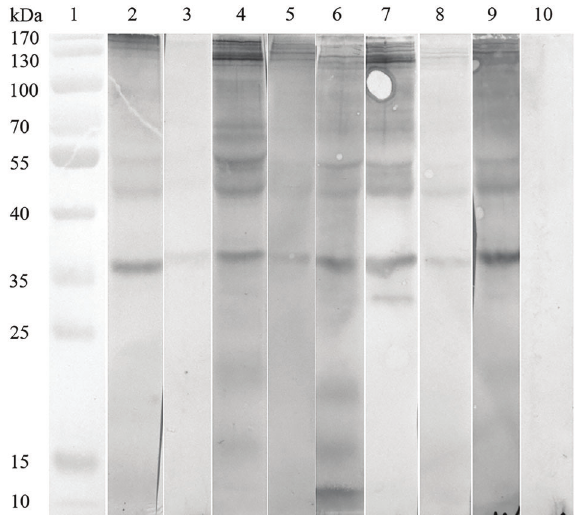
Figure 2 . SDS-PAGE and IgG1 immunoblotting of the crude antigen of Echinococcus granulosus cyst fl uid (EgCF). Crude antigens of EgCF protein extracts were incubated individually with 8 sIgG1 positive sera ( lanes 2 – 9 ), and with disease control ( lane 10 ); protein molecular weight marker ( lane 1 ). SDS-PAGE, sodium dodecyl sulfate-polyacrylamide gel electrophoresis; sIgG1, speci fi c immunoglobulin G1.